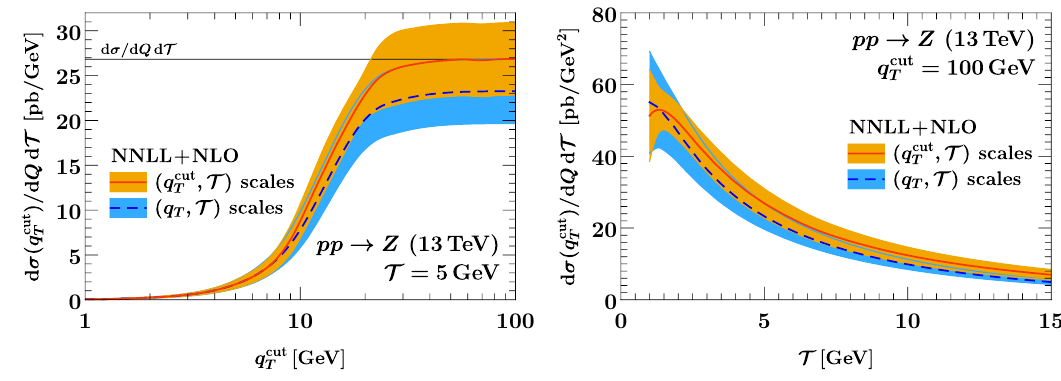
Figure 12 . The T spectrum with a cut on q T as a function of q cut at (cid:12)xed T = 5 GeV (left) T and as a function of T at (cid:12)xed q cut = 100 GeV (right). The bands indicate the total perturbative T uncertainty (cid:1) total , see section 3.4. The colors correspond to di(cid:11)erent scale setting prescriptions (default: solid orange); see the text for details.